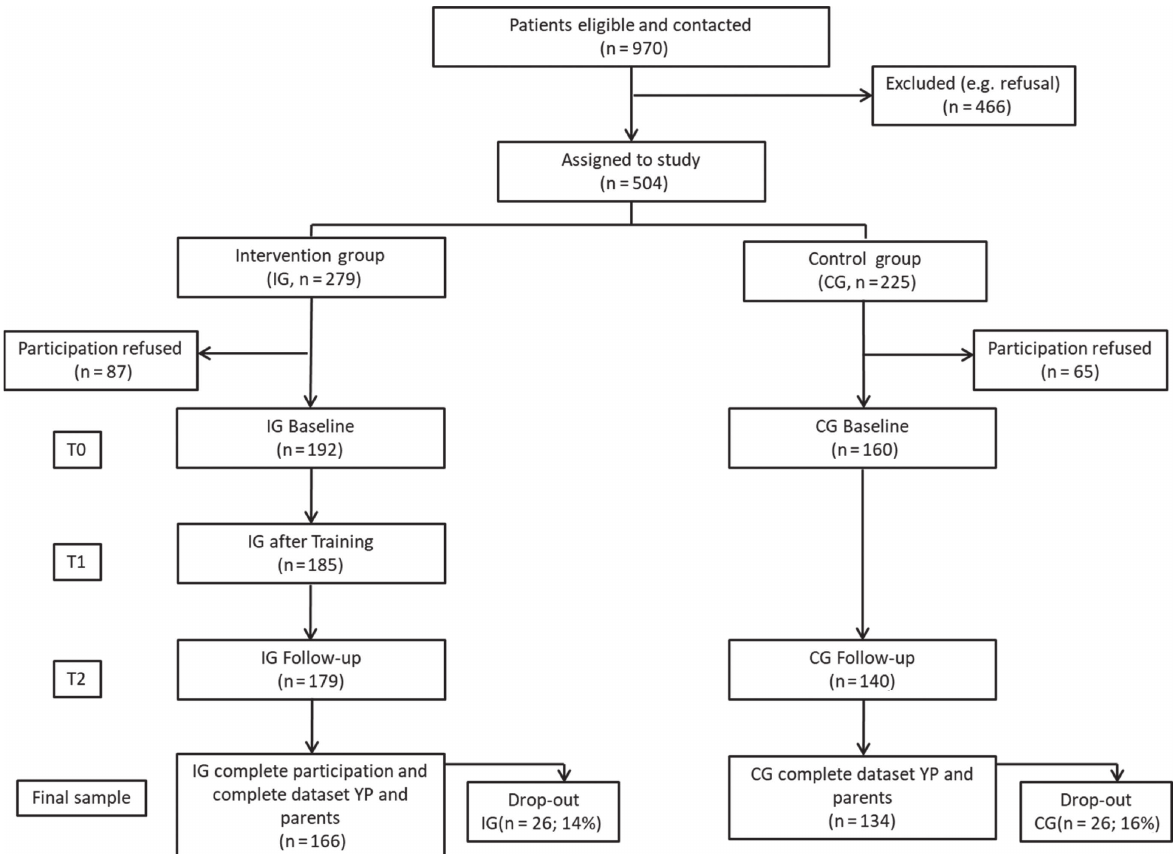
Figure 2: Flow of participants.